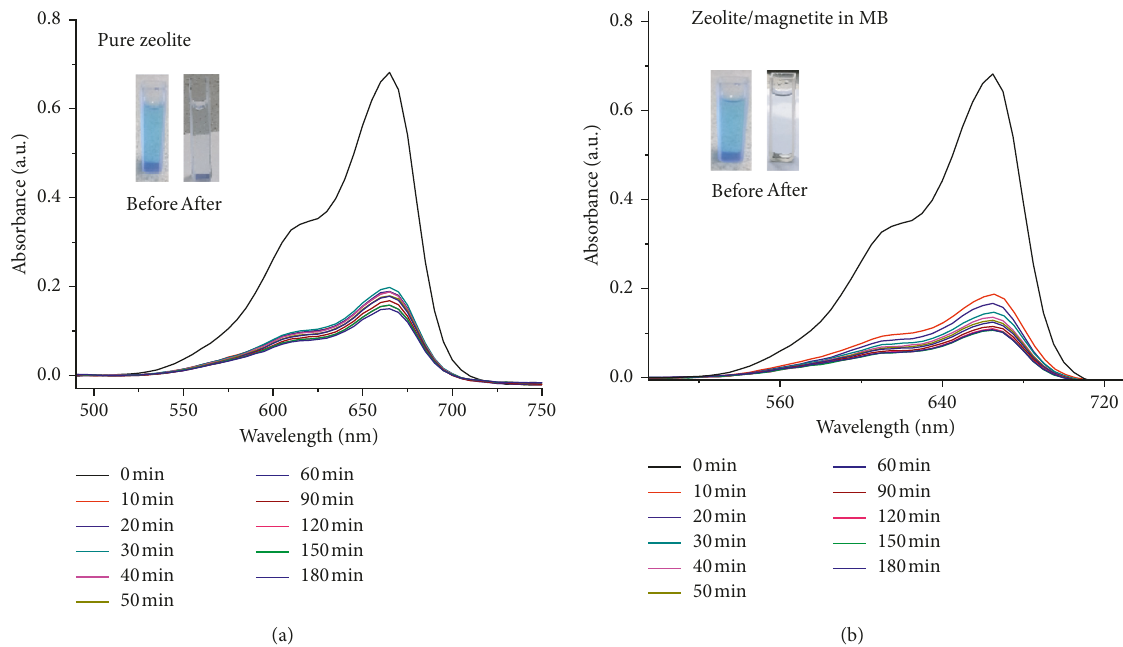
Figure 6: Absorbance intensity curve at various time intervals for (a) pure zeolite in MB (b) and zeolite/magnetite nanocomposite (Z-Fe NC) in